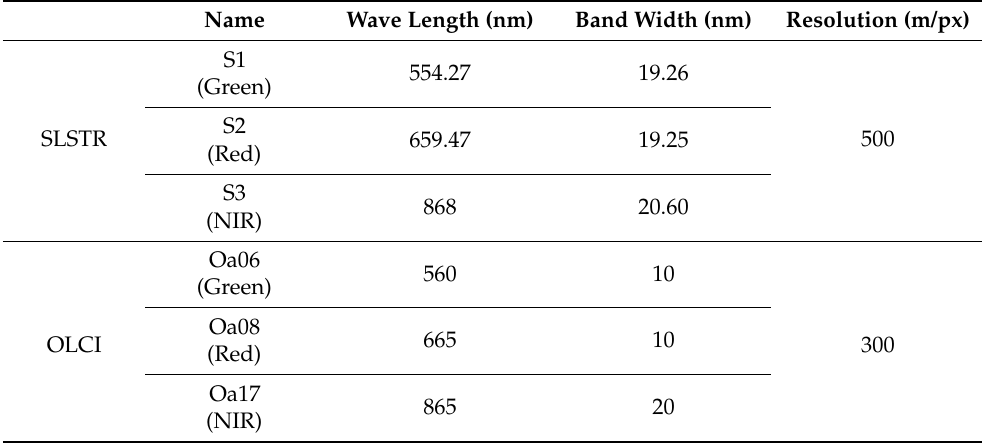
Table 2. Main characteristics of green, red and NIR bands for both SLSTR and OLCI instruments